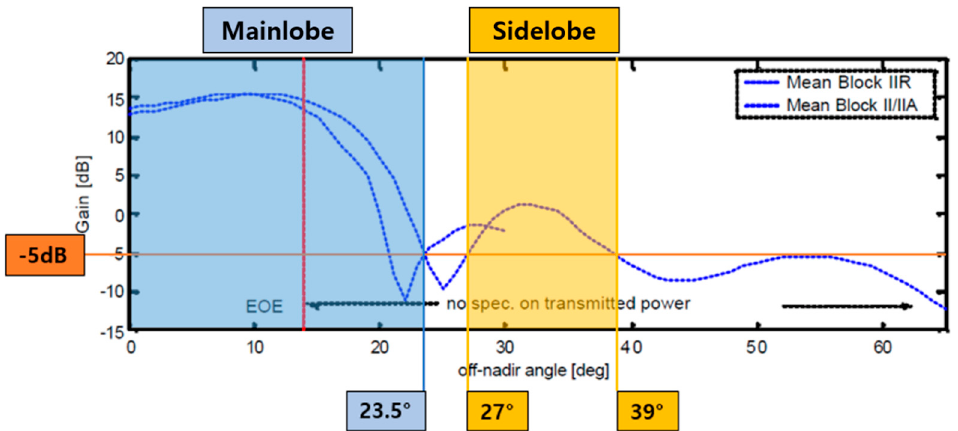
Figure 3. Mean gain patterns for the GPS Block II/IIA and Block IIR satellites [24].Adapted